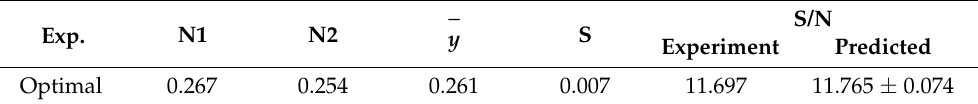
S/N ¯ y S Experiment Predicted